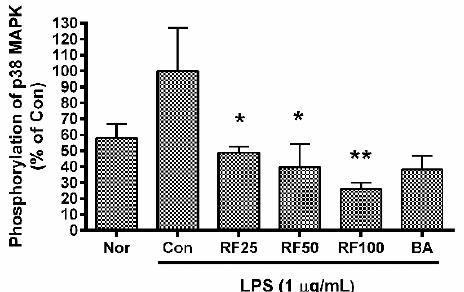
Figure 4. E ff ects of Rubi Fructus water extract (RF) on phosphorylation of p38 MAPK in RAW 264.7 cells. Cells were treated with LPS and RF for 30 min. “Nor” indicates the group treated with media only. “Con” indicates the group treated with 0.1 µ g / mL of LPS alone. RF25, RF50, RF100, and RF200 indicate treatment with 25, 50, 100, and 200 µ g / mL of RF, respectively. “BA” indicates treatment with baicalein (25 µ M). Values represent means ± SD of three independent experiments ( n = 3). Statistical significance was calculated by one-way ANOVA and a Tukey multiple comparison test. * p < 0.05 vs. Con; ** p < 0.01 vs. Con.